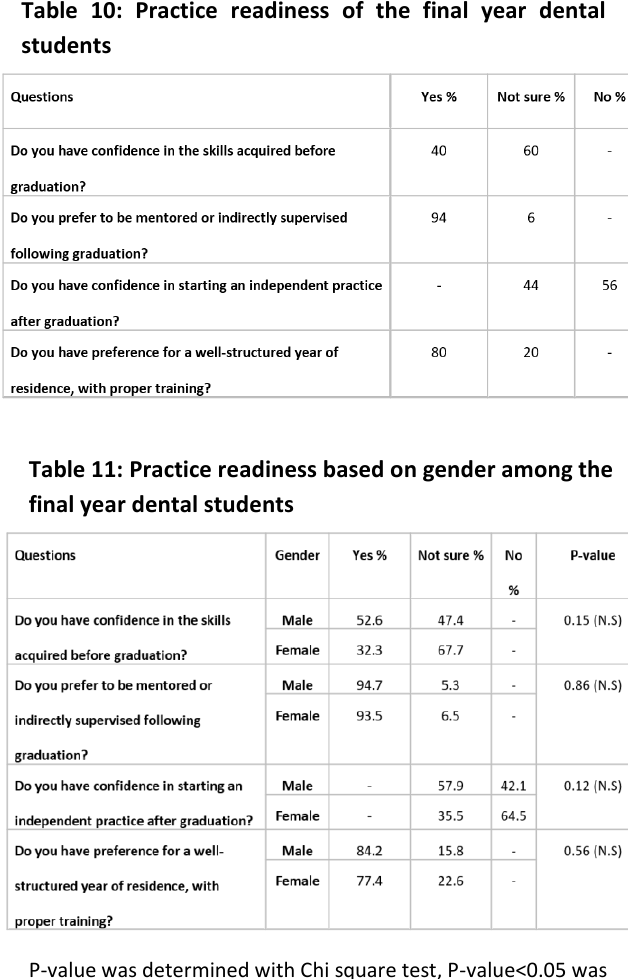
Table 10: Practice readiness of the final year dental